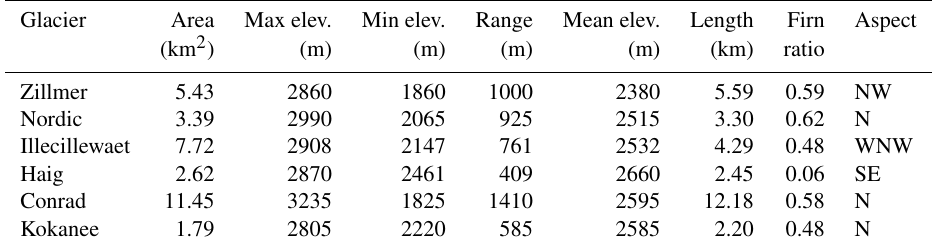
Table 1. Glacier-specific details. Firn ratio refers to the area of a glacier covered by multi-year firn, which is the combination of accumulation area and exposed firn from 2015 imagery.